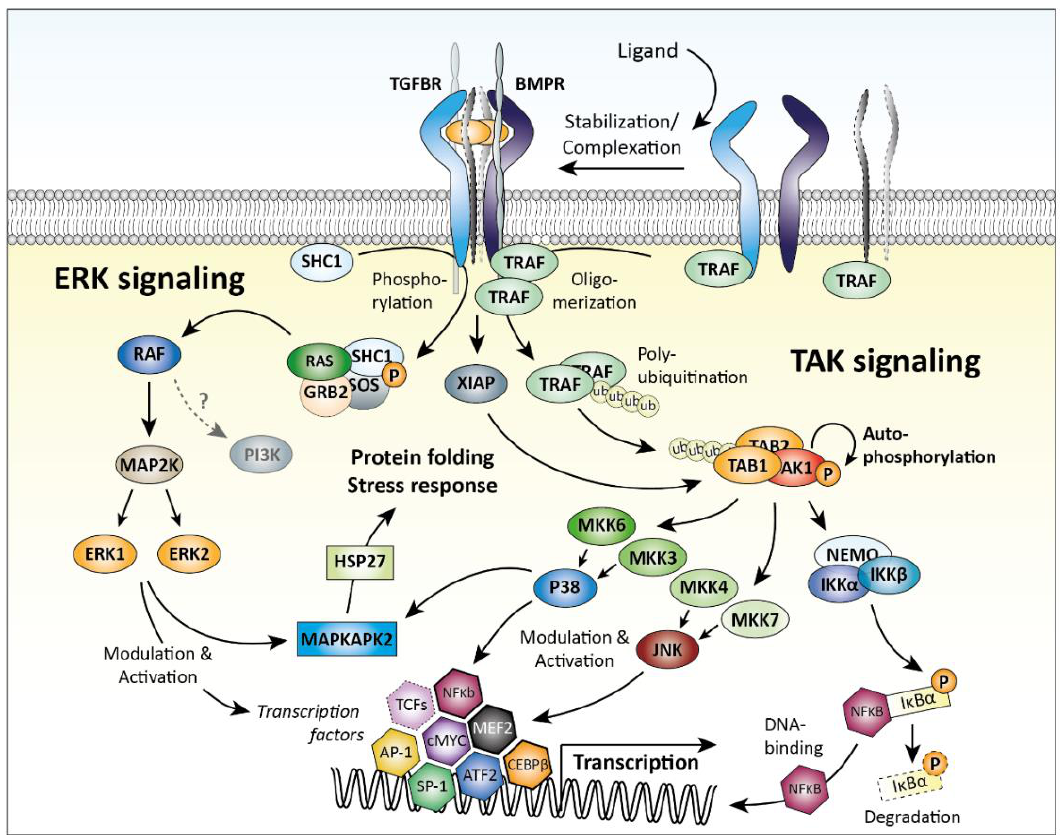
Figure 3. Transforming growth factor β (TGF β ) family SMAD-independent signaling. Ligand binding induces the formation of a receptor complex. This complex can initiate SMAD-independent signaling via activation of adaptor proteins, e.g., SHC1 and TRAF6. This activation results in initiation of the ERK and TAKsignalingcascades,culminatingintheactivationofMAPKAPK2,p38,JNK,andNF κ b. Thesepathways induce transcription and translation and regulate diverse cellular processes. AKT = RAC-alpha serine / threonine-protein kinase, AP-1 = Activator protein 1, ATF2 = Cyclic AMP-dependent transcription factor ATF-2, CEBP β = CCAAT / enhancer-binding protein β , ERK = Mitogen-activated protein kinase 3, GRB2 = Growth factor receptor-bound protein 2, HSP27 = Heat shock protein beta-1, IkBa = NF-kappa-B